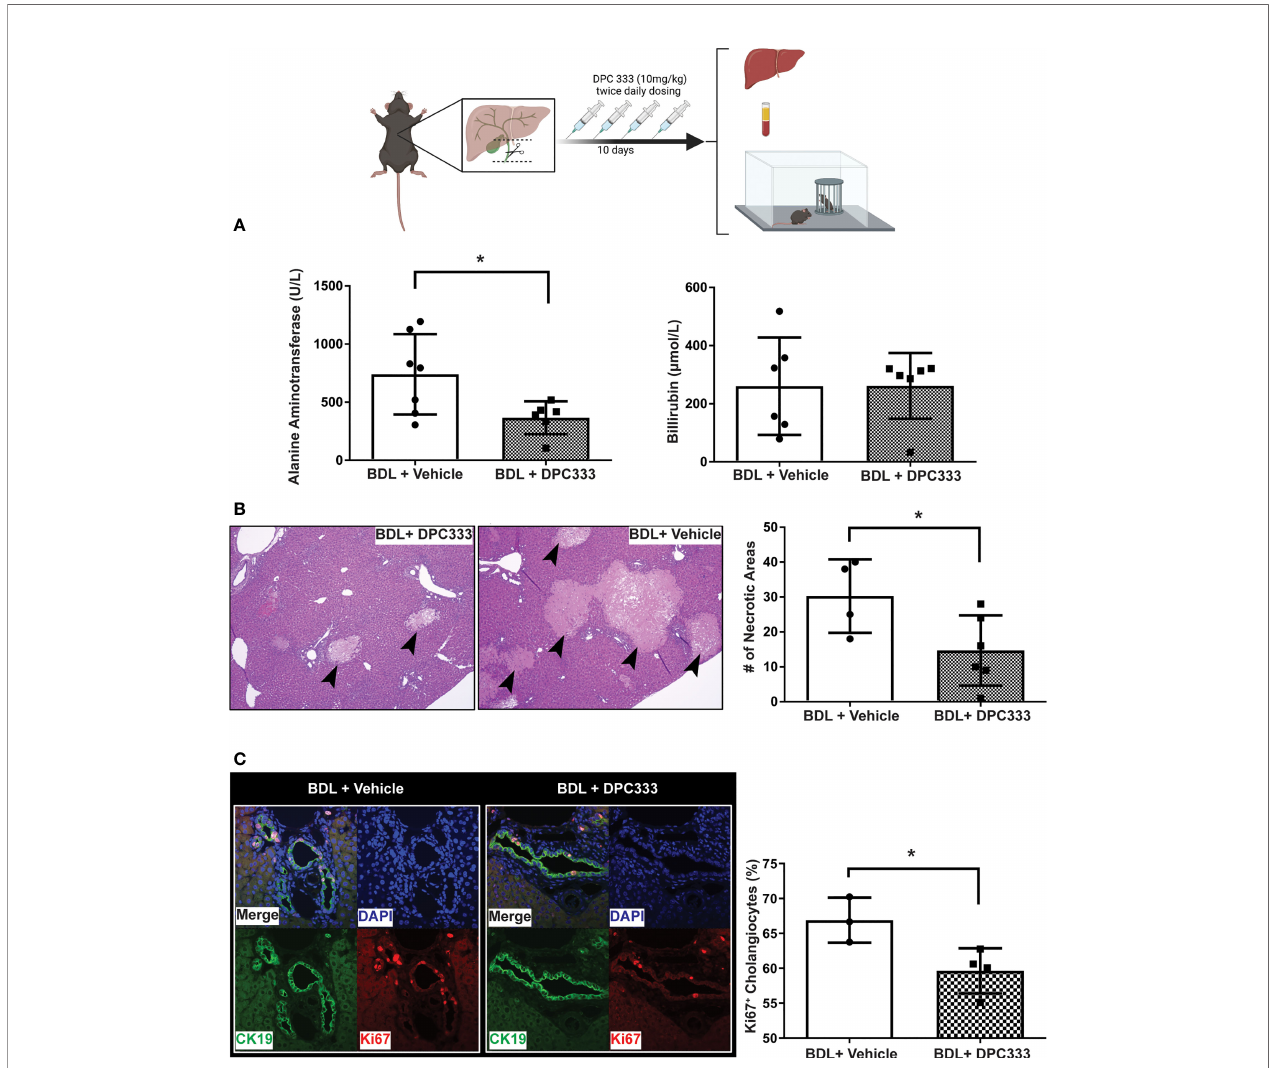
FIGURE 2 | Inhibition of ADAM17 enzymatic activity attenuates liver injury in BDL mice. Diagram of experimental design depicting bile duct ligation (dotted line) with resection in between ligatures in BDL mice. Twice daily treatment with DPC 333 (10 mg/kg) was provided via intraperitoneal injection. Mice were overtly cholestatic 10 days post surgery at which point experimentation was completed. (A) Improvement in serum ALT levels (but not total bilirubin levels) in DPC 333-treated BDL vs vehicle- treated BDL mice (mean ± SEM of data from n = 7 DPC 333 treated BDL mice and n = 7 vehicle treated BDL mice; *p < 0.05). (B) Representative H&E stained liver sections showing reduction in areas of liver cell necrosis (thick black arrows) in DPC 333-treated vs vehicle-treated BDL mice. Images are 20X and are representative of n = 7 DPC 333 treated group and n = 6 vehicle treated group). Bar graph shows counting of necrotic areas by blinded liver pathologist (DPC 333 treated 14.7 ± 4.1 vs. vehicle treated 30.2 ± 5.3; p < 0.05; n = 6 BDL + DPC 333 mice and n = 4 BDL + vehicle mice). (C) Attenuation of bile duct proliferation in BDL mice with DPC 333 treatment vs vehicle (PBS). Representative immunohistochemistry of BDL livers with and without DPC 333 showing CK19 (green), Ki67 (red) and nuclear staining (blue). Bar graph quanti fi cation done in a blinded manner with signi fi cant reduction in Ki67+ cholangiocytes in BDL mice treated with DPC 333 vs vehicle (PBS). *p < 0.033; n = 3 and 4